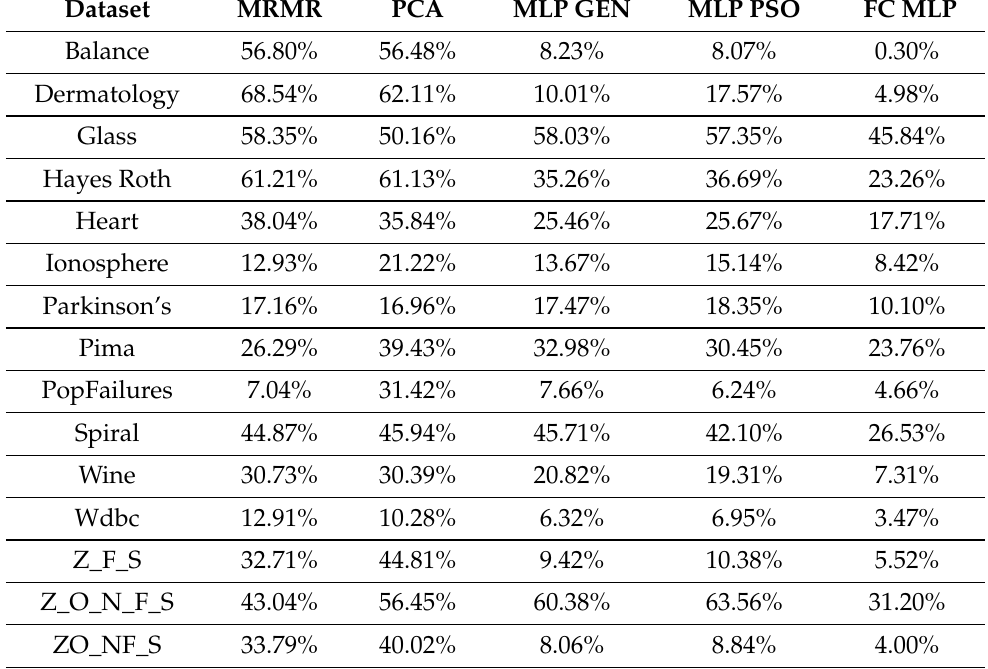
Table 4. Experimental results for classification datasets.